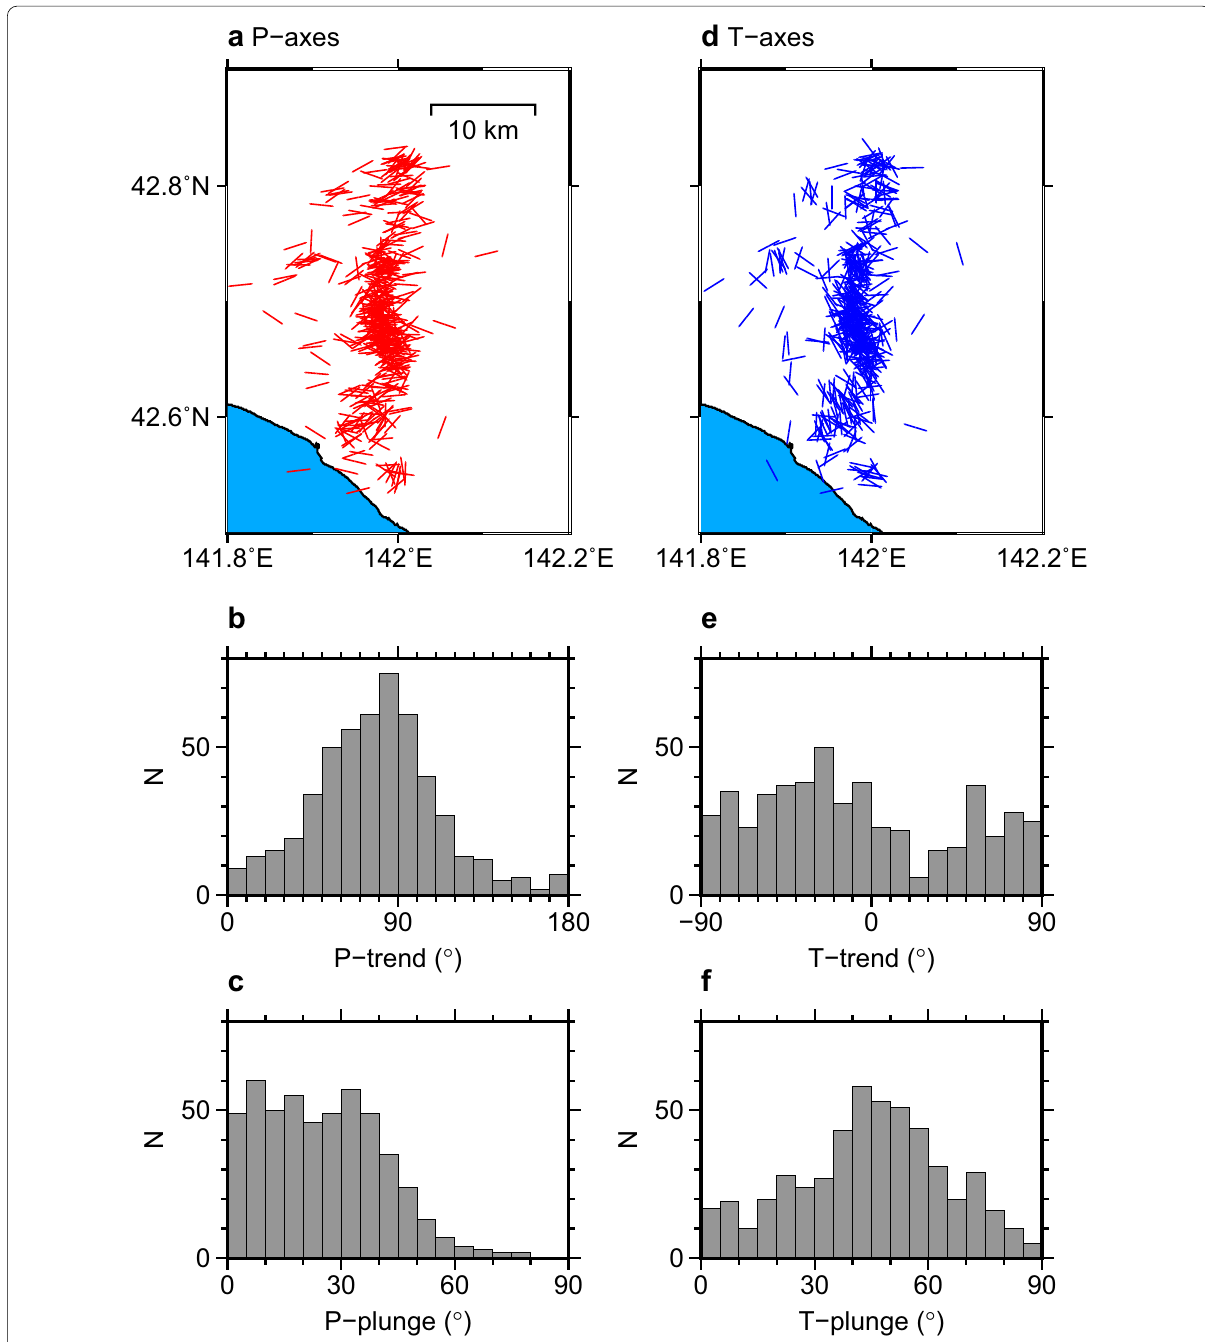
Fig. 5 Orientation of a P- and d T-axes of the focal mechanisms with Quality A and B shown in Fig. 4. Red lines in a and blue lines in d indicate the trend of the P- and T-axes, respectively. Histograms of the trend of b P- and e T-axes. Histograms of the plunge of c P- and f T-axes. The plunge of 0° and 90° indicate horizontal and vertical axes,